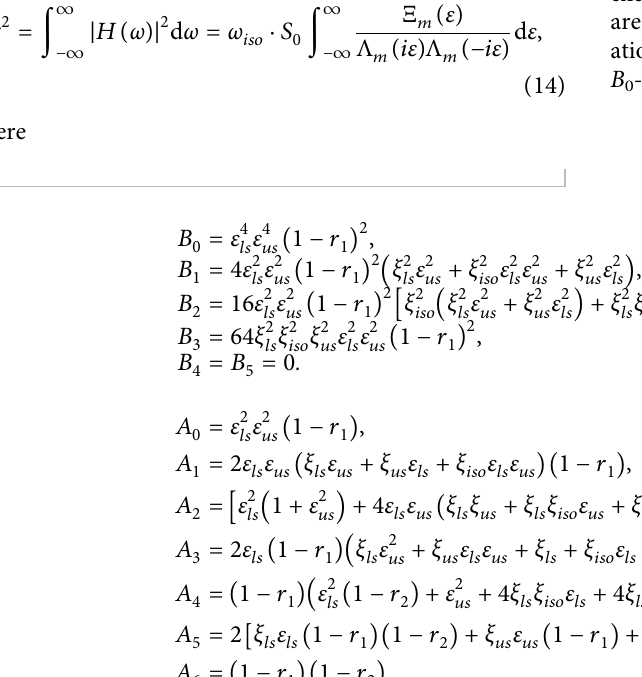
� 4): (a) r � 0.8 and (b) r ls ( ε us 2